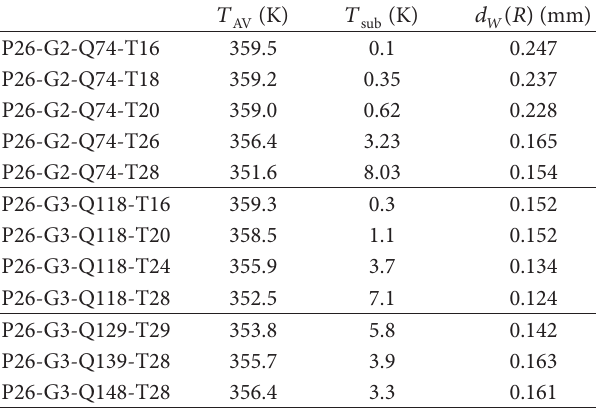
T 3: Parameters used for the bubble detachment